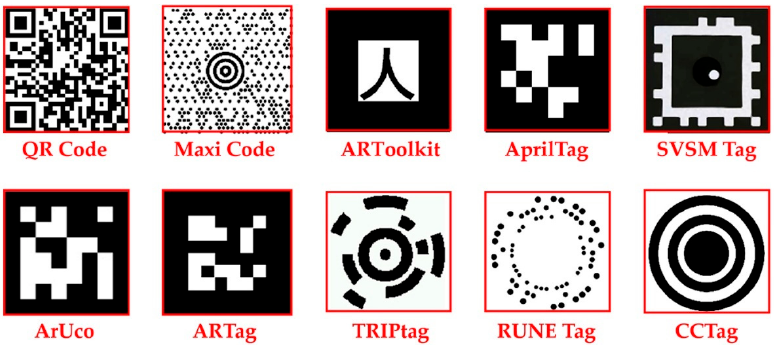
Figure 12. Some examples of markers recognizable through image recognition.